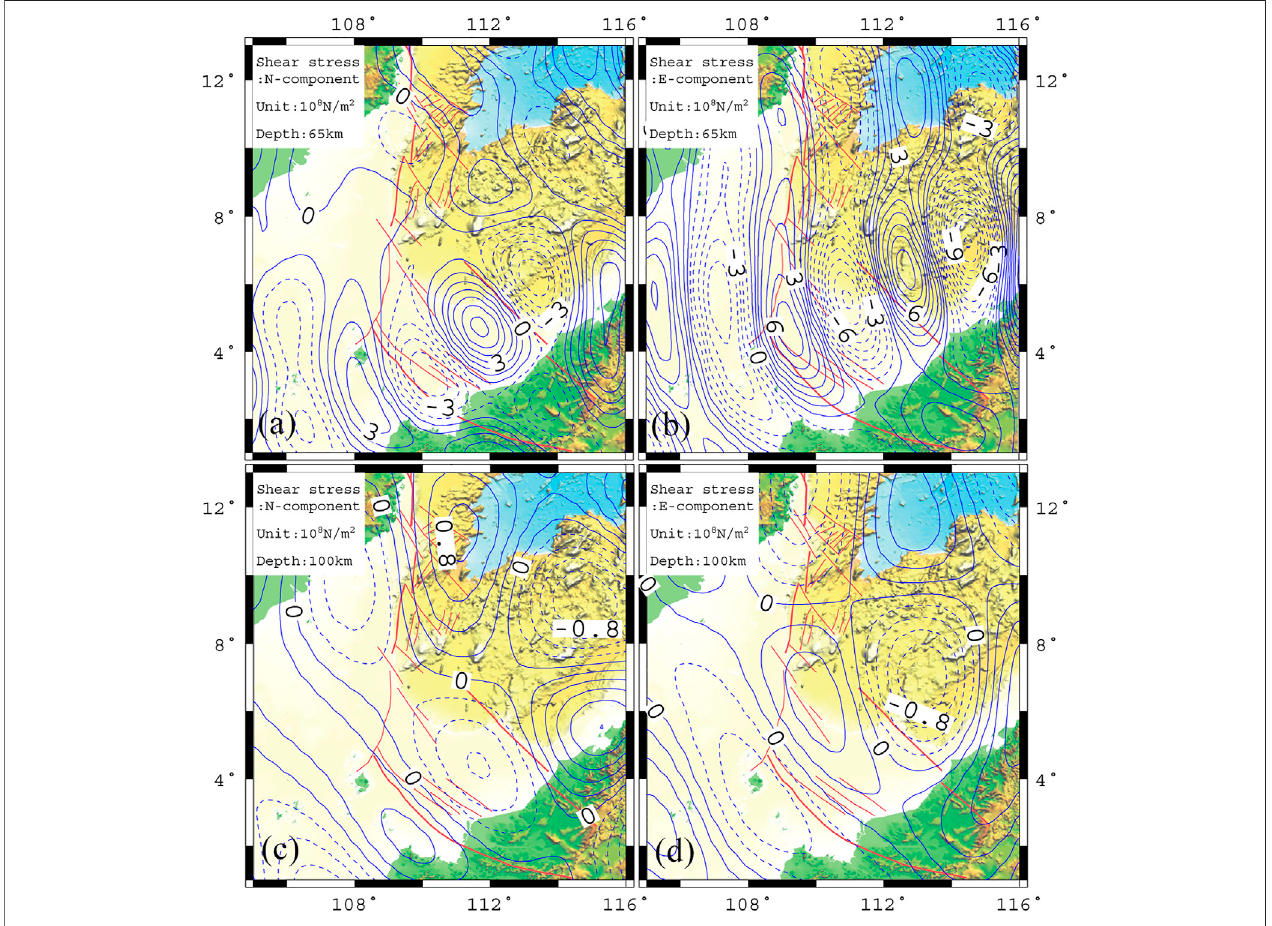
FIGURE 5 | Stress fi eld at the rheological boundary of the upper mantle in the southwestern margin of South China Sea. (A) Northward shear stress τ N at 65-km depth. (B) Eastward shear stress τ E at 65-km depth. (C) Northward shearstress τ N at 100-km depth. (D) Eastward shearstress τ E at 100-km depth. τ N — positivein the north and negative in the south; τ E — positive in the east and negative in the